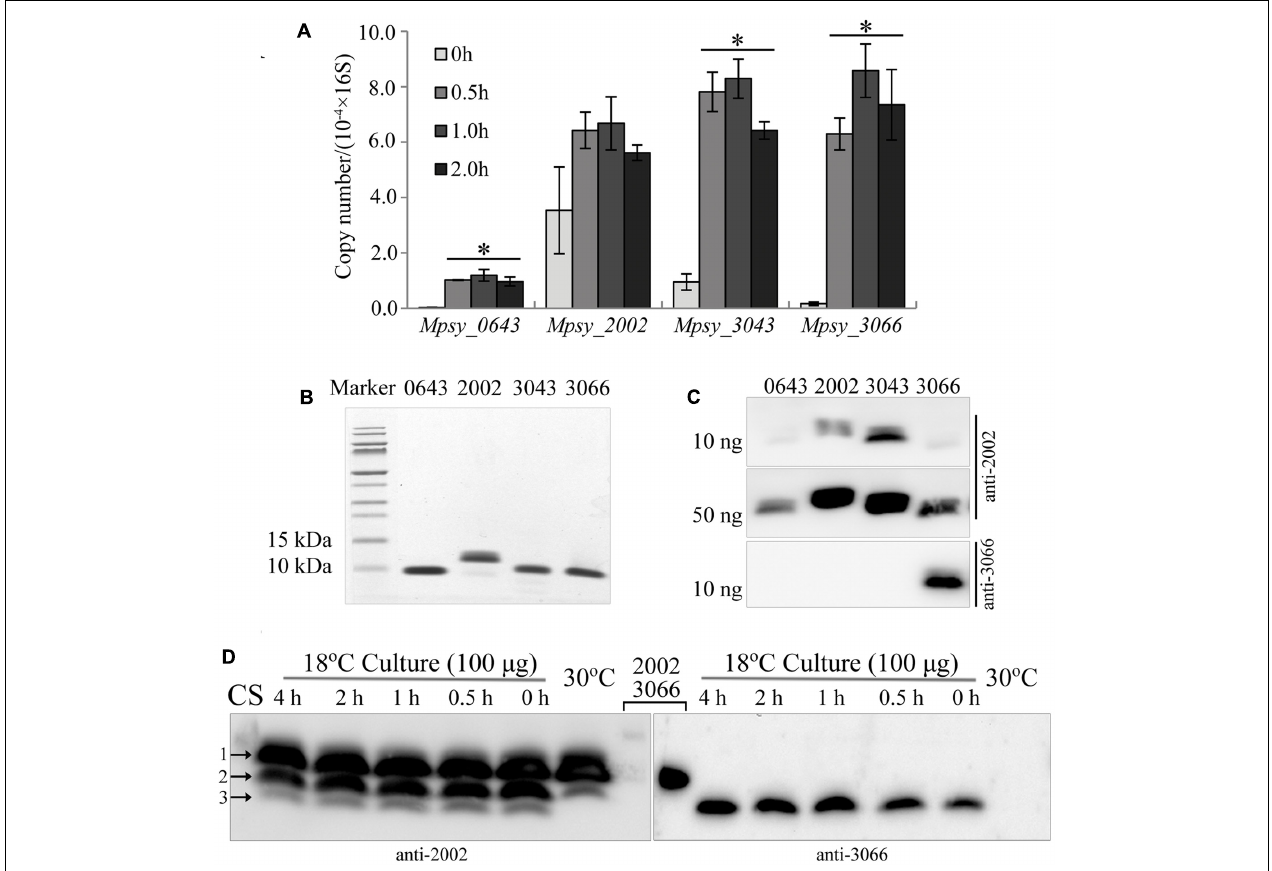
FIGURE 1 | Cold-responsive transcription and translation profiles of the TRAM encoding genes in Methanolobus psychrophilus R15. (A) Quantitative PCR-determined cold-shock induced transcription of four TRAM genes. Three batches of the middle exponential culture grown at 30 ◦ C were 4 ◦ C-cold shocked for the indicated time before total RNA was extracted. Using the specific PCR primers listed in Supplementary Table S2 and the PCR thermocycler parameters described in section “Material and Methods,” the cDNA fragment was amplified. The transcript copy number of each TRAM was calibrated against its calibration curve and normalized against the 16S rRNA copies. The mean and standard deviation are shown. ∗ Statistically significant difference verified by Student’s t -test ( P < 0.05). (B) Assays of the purified His6-tagged recombinant TRAM proteins on Tricine-SDS-PAGE. (C) Recognition of TRAM2002 and TRAM3066 antibodies to the proteins detected by Western blot. Numbers on the top of gels represent the four TRAMs. (D) Cold-responsive translation profiles of the four TRAMs. Each 100 µ g of total protein from strain R15 that was grown at 30 and 18 ◦ C, and the 4 ◦ C-cold shocked 18 ◦ C-culture was electrophoresed using a gradient (10–16%) Tricine-SDS-PAGE. The gel was cut in the lane middle that loaded with a mixture of each 10 ng of His6-tagged TRAM2002 and TRAM3066 (lanes 2002 and 3066), and respectively transferred to 0.1- µ m nitrocellulose filter membrane. Using the antibodies against TRAM2002 (left) and TRAM3066 (right), Western blot probed the abundance of the four TRAM proteins. The signals of TRAM2002 and TRAM3066 (Lane 2002 and 3066) could only be seen when extend exposure time (data not shown). Arrows indicted TRAM2002 (1), TRAM3043 (2) and a mixture of TRAM 3066 and TRAM0643 (3) by referencing markers and their molecular weights. CS, cold